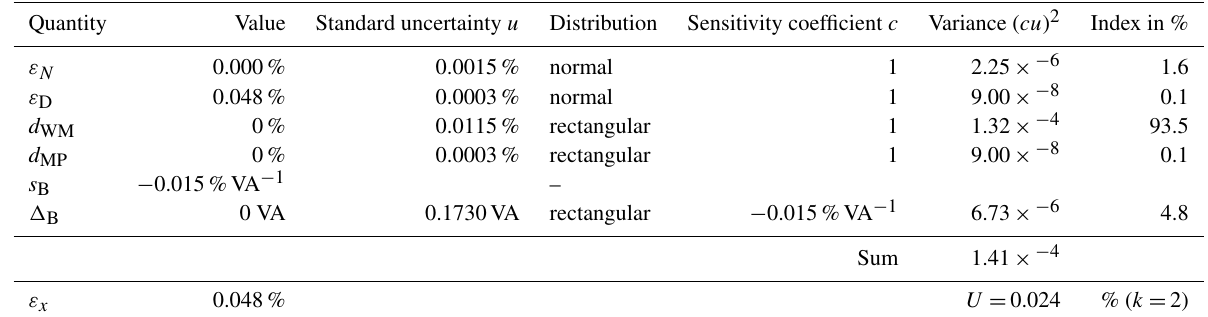
Table 2. Uncertainty budget of the ratio error for a class 0,2S instrument transformer at a signal amplitude I n of 100% and a rated burden S n =